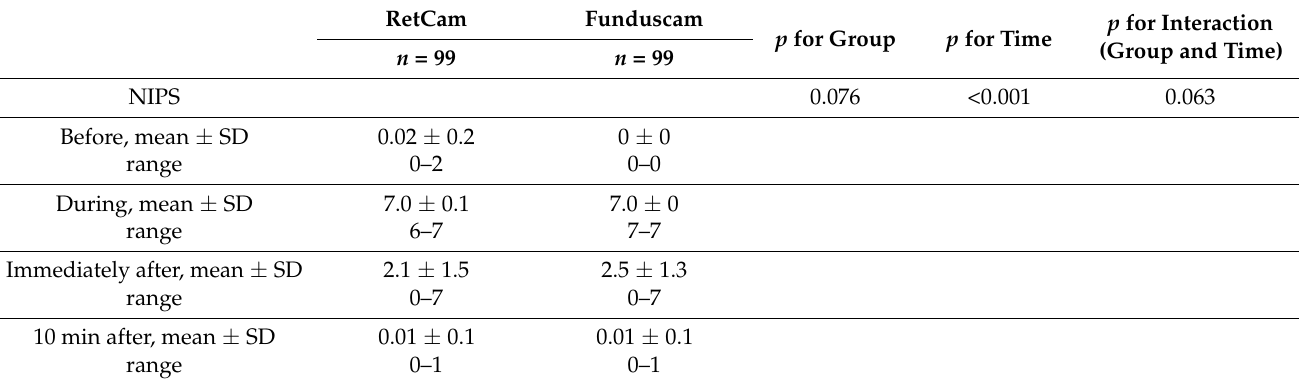
Table 5. Pain score and adjustments during